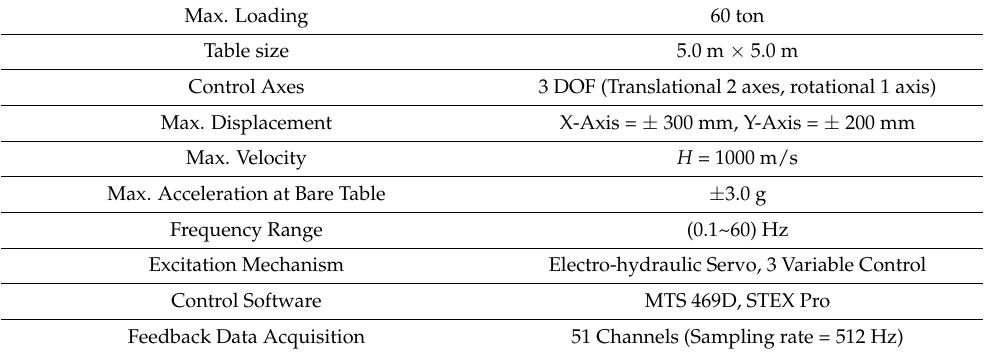
Figure 10. Locations of the measurement sensors: ( a ) attachment of the steel plate at the column section, ( b ) locations of the strain gauges, and the ( c ) locations of the accelerometers and displacement transducers (unit: mm). Table 3. Specification of shaking